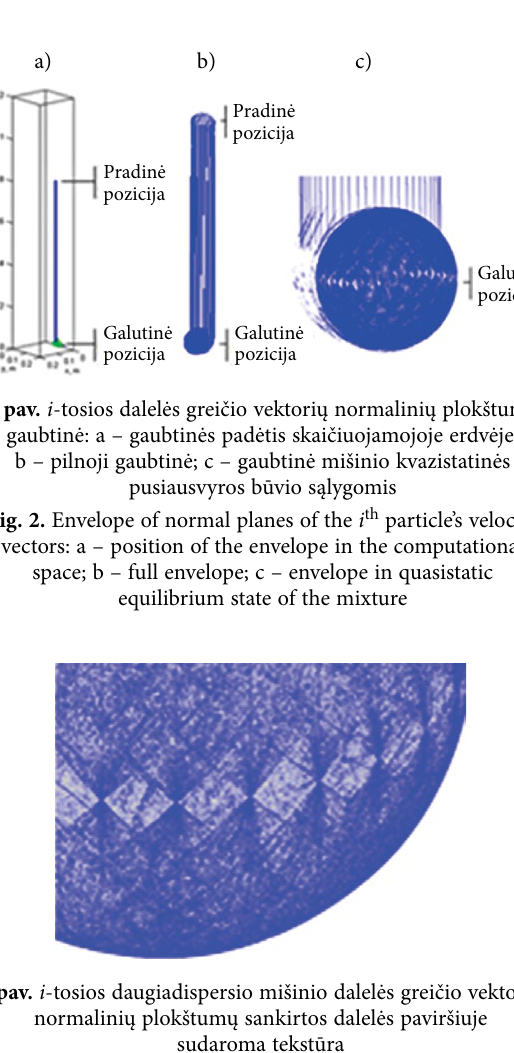
Fig. 3. Texture formed on the surface of the particle of the intersection between normal planes of the i th polydispersed mixture particle’svelocity